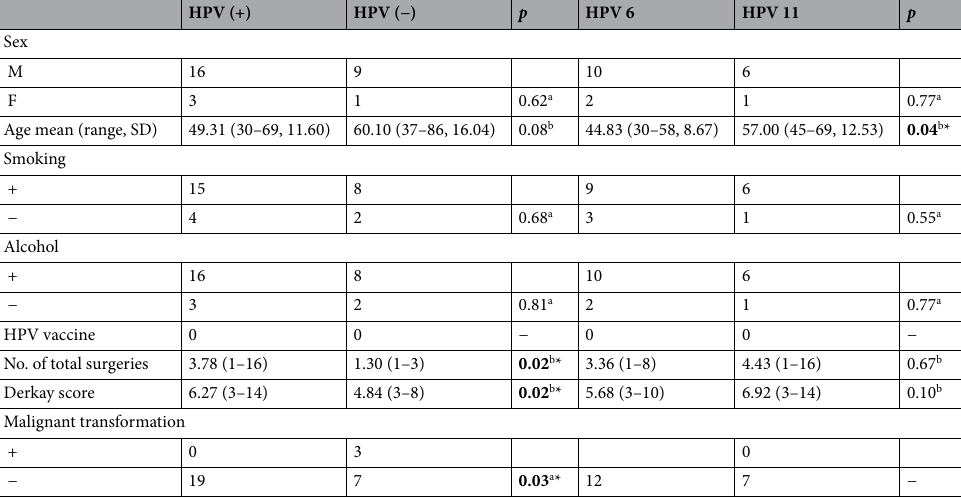
Table 1. Patient characteristics. Significant values are in [bold]. HPV Human papillomavirus, M Male, F Female, SD Standard deviation. *Indicates p < 0.05. Data for the two populations in the two categories are subjected to a Fisher’s exact test. A Welch’s t-test is applied to compare two sets of data. a Indicates Fisher’s exact test. b Indicates Welch’s